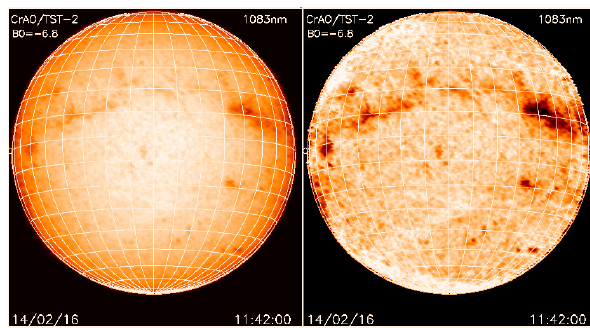
Figure 5. Full-disk images of the Sun obtained on February 14th, 2016 in the He I 1083 nm line